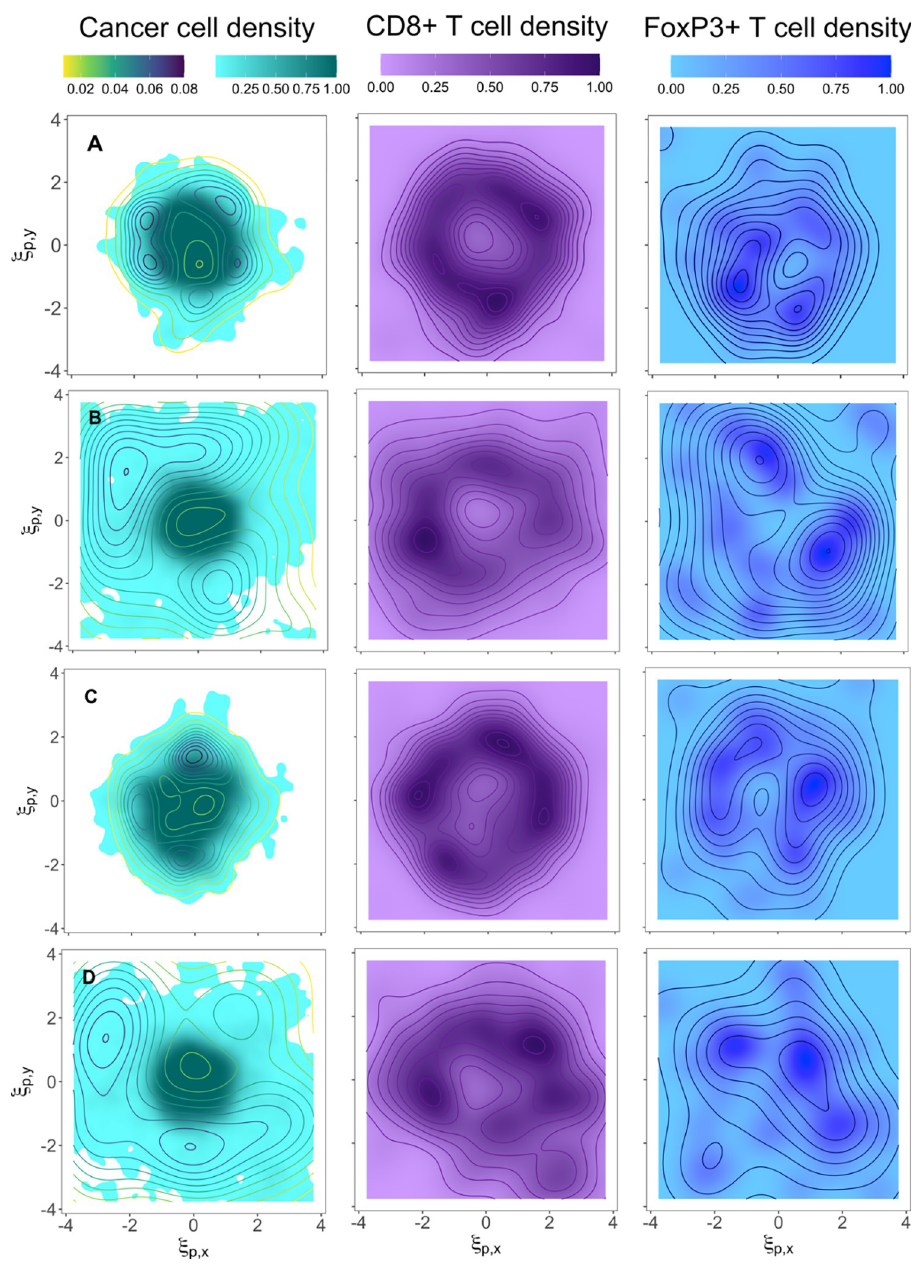
Fig 4. Spatial distributions of cell densities under different tumor growth conditions. Cancer cell, CD8+ T cell, and FoxP3+ T cell densities are normalized and represented in turquoise, purple, and blue scale bars, respectively. CSC density distributions are represented in the first column of contour plots as yellow-to-blue lines. ξ p,y = y/ y x/ x ref are non-dimensional spatial coordinates with y ref = x ref = 2u p /r p . Four different scenarios are presented: similar migration and proliferation effects, R ~ 1, 10% of the grid occupied by voxels with cell recruitment sources, and d 9 (panel A); fast migration of CSCs and proliferation of PCs, R < 1, 10% of the grid occupied by voxels with cell recruitment sources, and d max = 9 (panel B); R ~ 1, 10% of the grid occupied by voxels with cell recruitment sources, and d = 4 (panel C); R < 1, 30% of the grid occupied by voxels with cell recruitment sources, and d max D). The spatial QSP algorithm calculated the evolution of three-dimensional tumors starting from a normal distribution of cancer cells located at the center of the grid. QSP model and ABM are coupled before reaching the point where T cells are recruited and also before the initial tumor diameter condition from the QSP model is met. Thus, no initial T cell spatial distribution is enforced. The figures show the cancer cell density in a two-dimensional slice at the center of the tumor 10 months after the initial tumor diameter condition is met. The scaling factor is γ =50000 in all